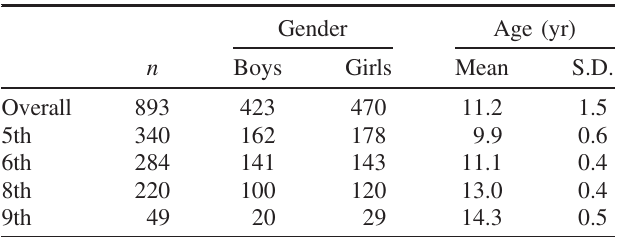
TABLE I. Descriptive statistics of the